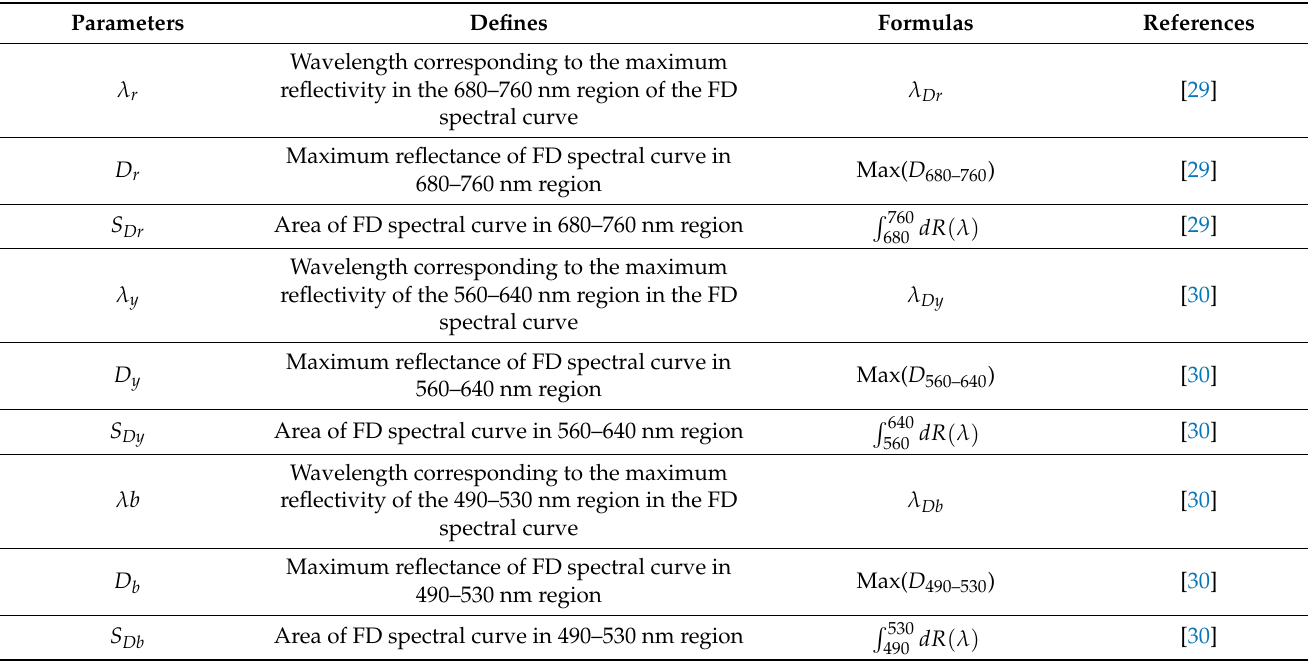
Table 2. “Three-edge” parameters based on first-order differential (FD)